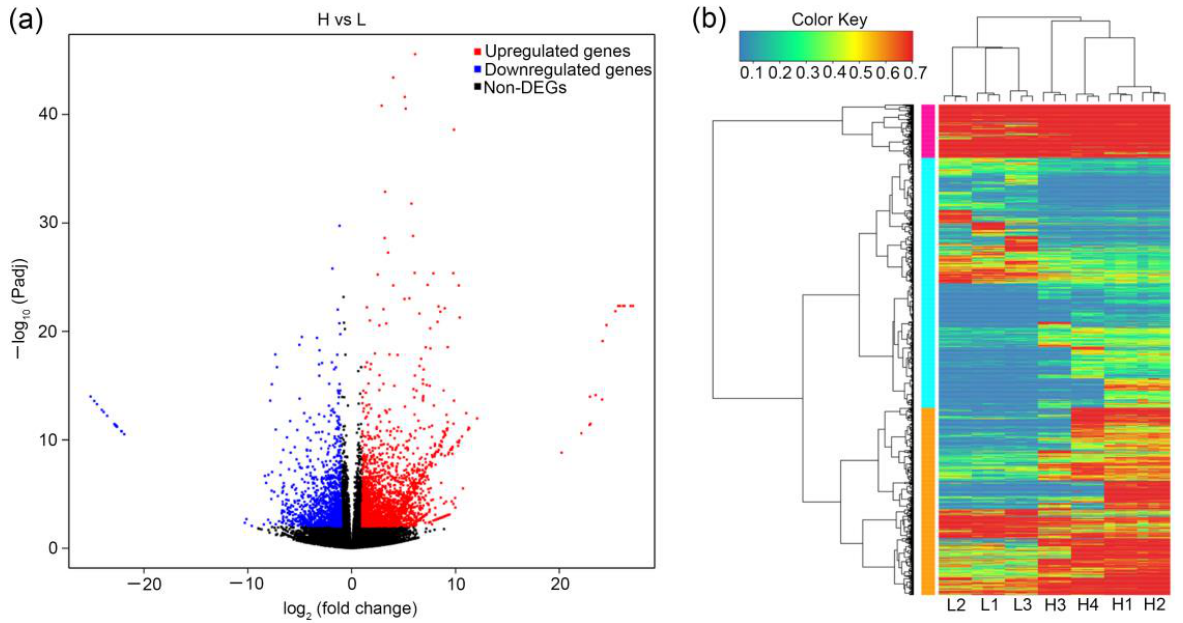
Figure 2. The volcano and cluster maps of differentially expressed genes (DEGs) between two groups with high and low thujone content. ( a ) The volcano map of DEGs between two groups with different thujone content. ( b ) The cluster maps of seven materials based on DEGs between two groups. H1, H2, H3, and H4 indicate four varieties with high thujone content. L1, L2, and L3 indicate three varieties with low thujone content.